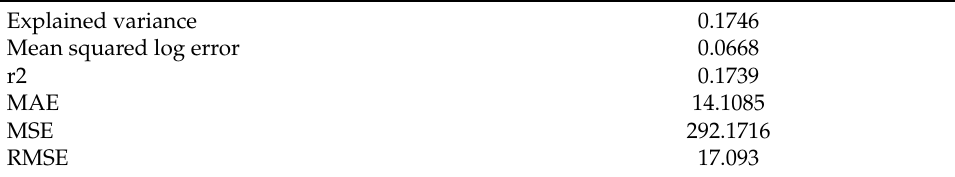
Table 8. Multiple Linear Regression Evaluation Parameters.